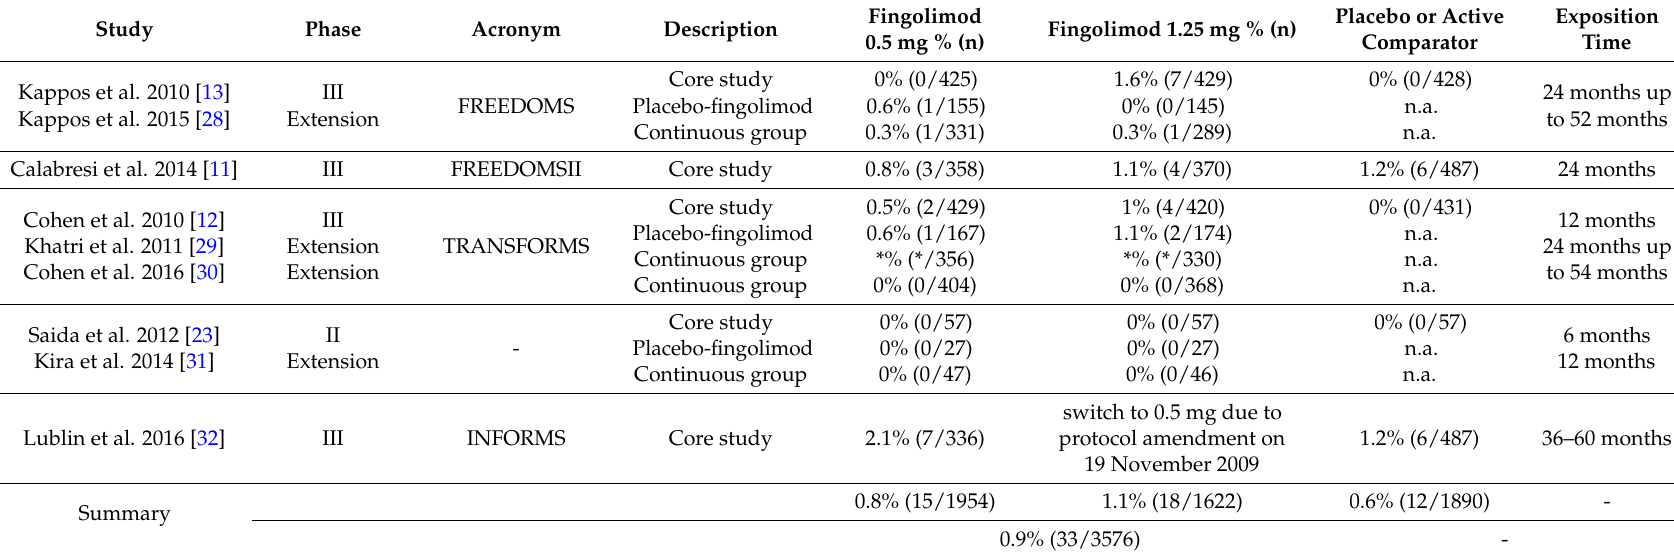
Table 2. Frequency of macular edema in multiple sclerosis clinical trials. Percentage incidence was calculated by dividing the number of macula edema cases in the study by the total population enrolled in the reviewed studies. * One case of macular edema has been reported in the continuous fingolimod group but without specifying the fingolimod dosage. n.a. = not